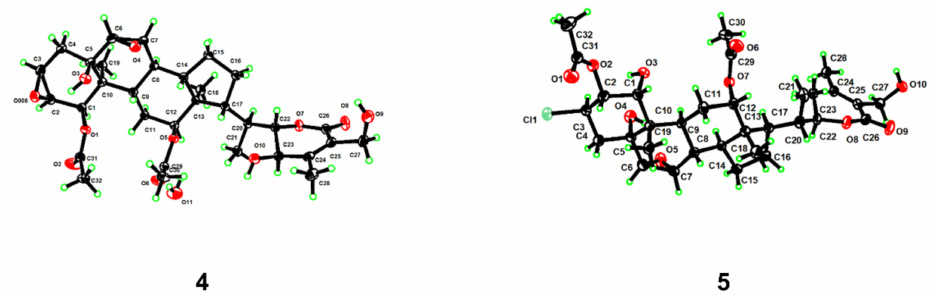
Figure 4. Perspective ORTEP drawings for compounds 4 and 5 .